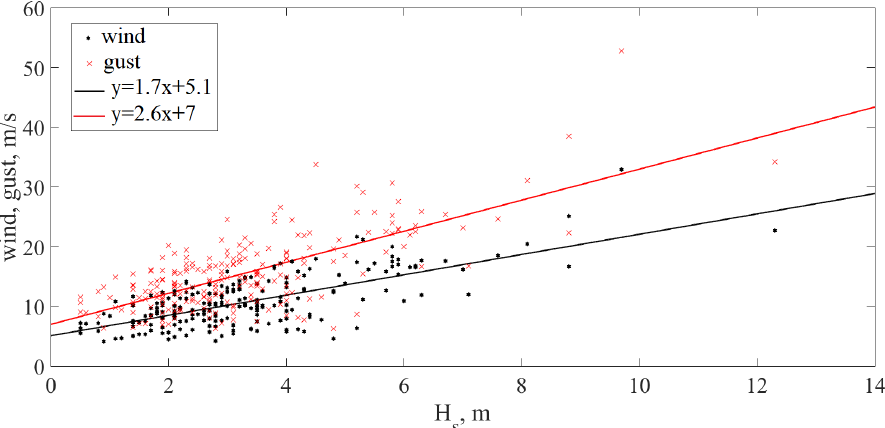
Figure 13. Dependence of wind speed and gusts on significant wave heights for coastal freak wave